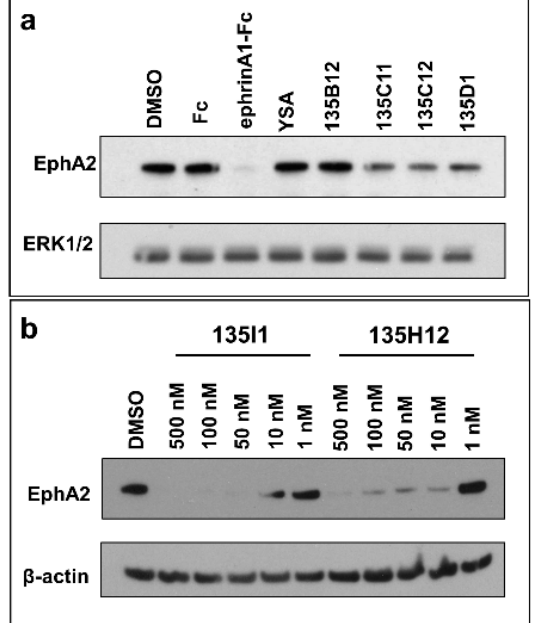
Figure 3. Dimeric and tetrameric EphA2 agonistic ligands degrade EphA2 receptor. ( a ) Western blot study of HCT116 cells treated with ephrinA1-Fc, EphA2 agonistic monomers (YSA, 135B12), and EphA2 agonistic dimers (135C11, 135C12, and 135D1) for 2.5 h (10 µ M each). Total anti-EphA2 blot indicates that ephrinA1-Fc treatment led to complete degradation of the receptor, while EphA2 dimeric ligands treatments showed partial decrease of the receptor. Total ERK1 / 2 blot was used as a loading control. ( b ) Pancreatic cancer BxPC3 cells were treated with tetrameric (135I1) and dimeric (135H12) compounds for 1 h. These compounds successfully degraded EphA2 receptor at nanomolar concentrations.